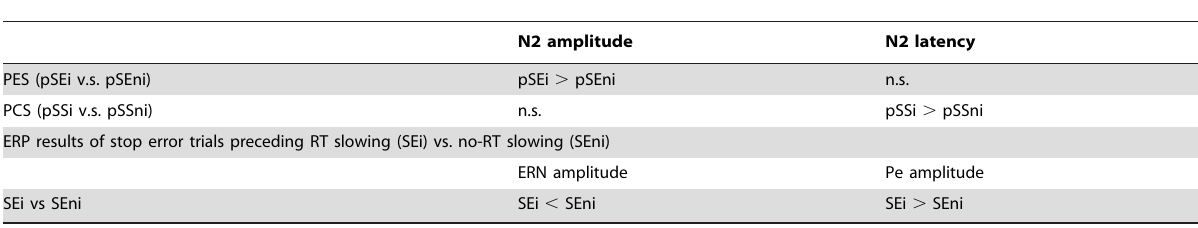
Table 2. ERP results of post-error slowing (PES) and post-conflict slowing